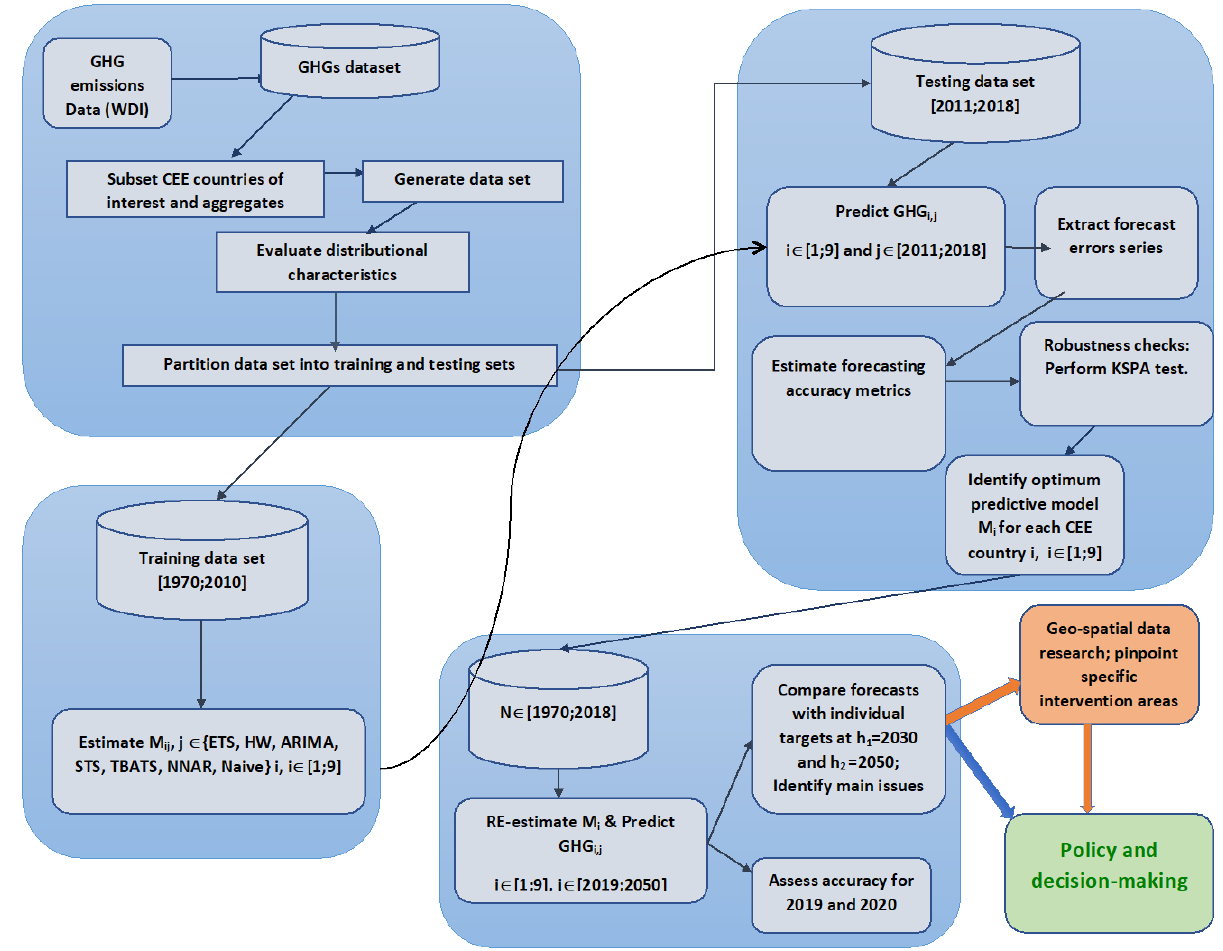
Figure 4. Research methodology flowchart.